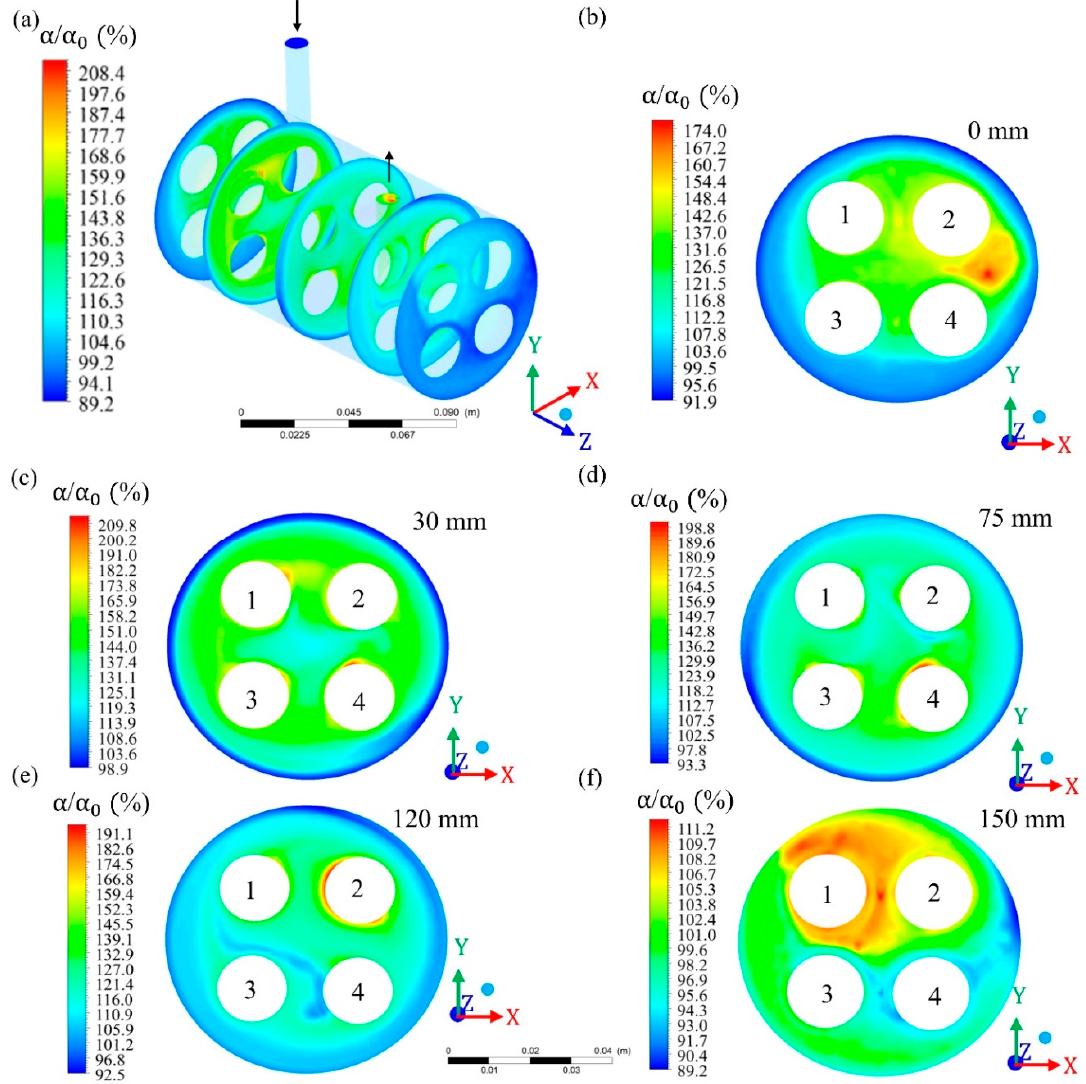
Figure 7. Field of relative oil volumetric fraction in different regions of the hull; ( a ) general view and in the xy plane at ( b ) z = 0 mm; ( c ) z = 30 mm; ( d ) z = 75 mm; ( e ) z = 120 mm; and ( f ) z = 150 mm, of the filtration module during the water/oil separation process.